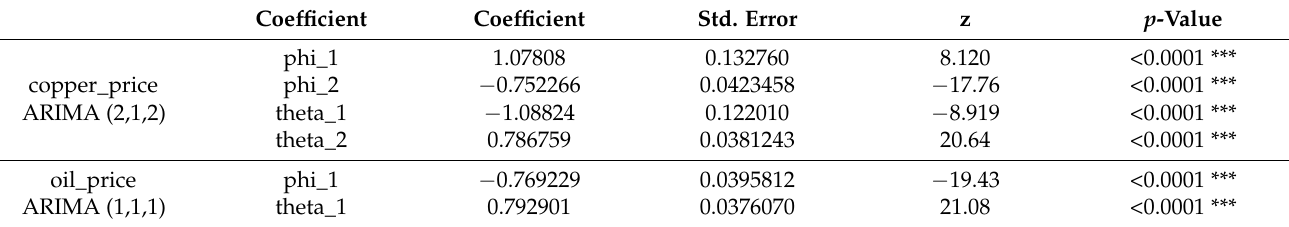
Table A1. Statistic of time-series.